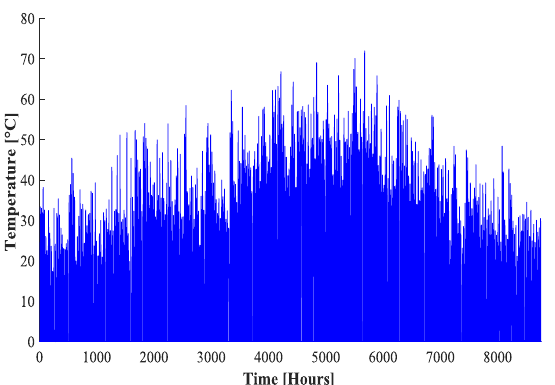
Fig. 12 Annual database of the cell temperature [°C]